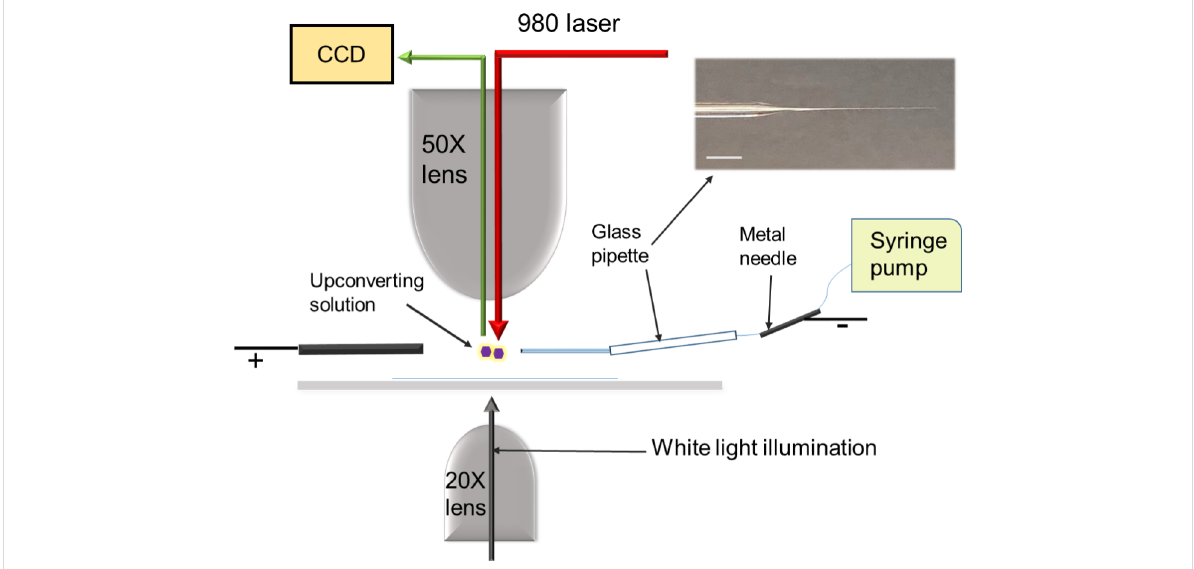
Figure 8: A schematic illustration for a setup of temperature measurement in a Taylor cone, formed by electrospray of an upconverting solution. A 980 nm laser illuminates from the top with a 50× lens. A white light illuminates from the bottom using a 20× lens for imaging. The image on the top right shows a glass capillary pulled to form a ca. 15 μ m pipette. The scale bar is 2